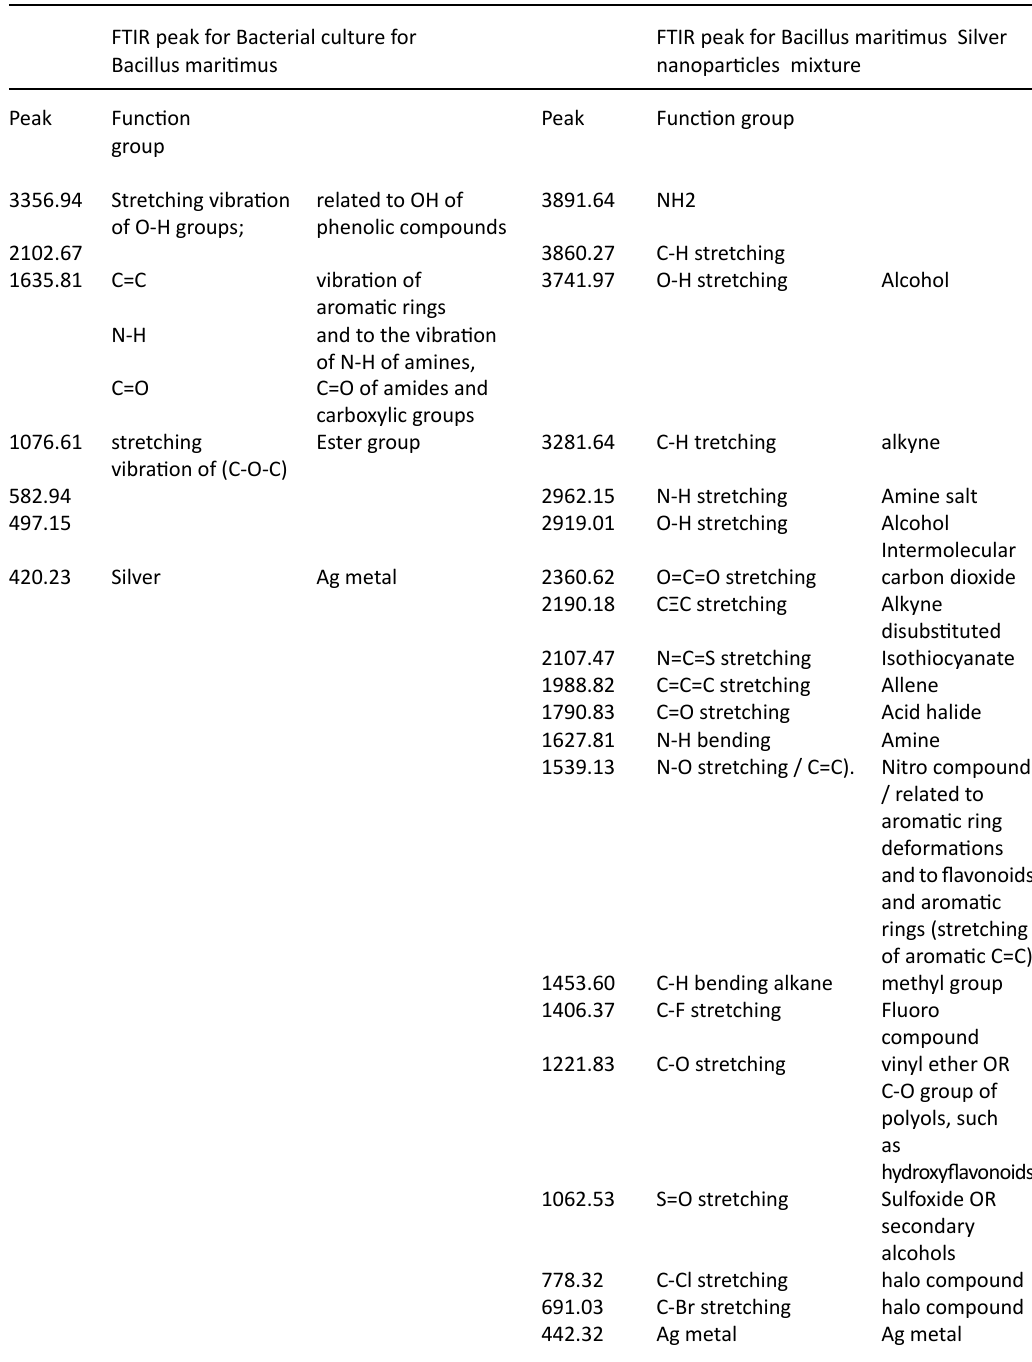
Table 4. FT-IR analysis of function group in Bacillus maritimus culture and Bacillus maritimus culture silver nanoparticles